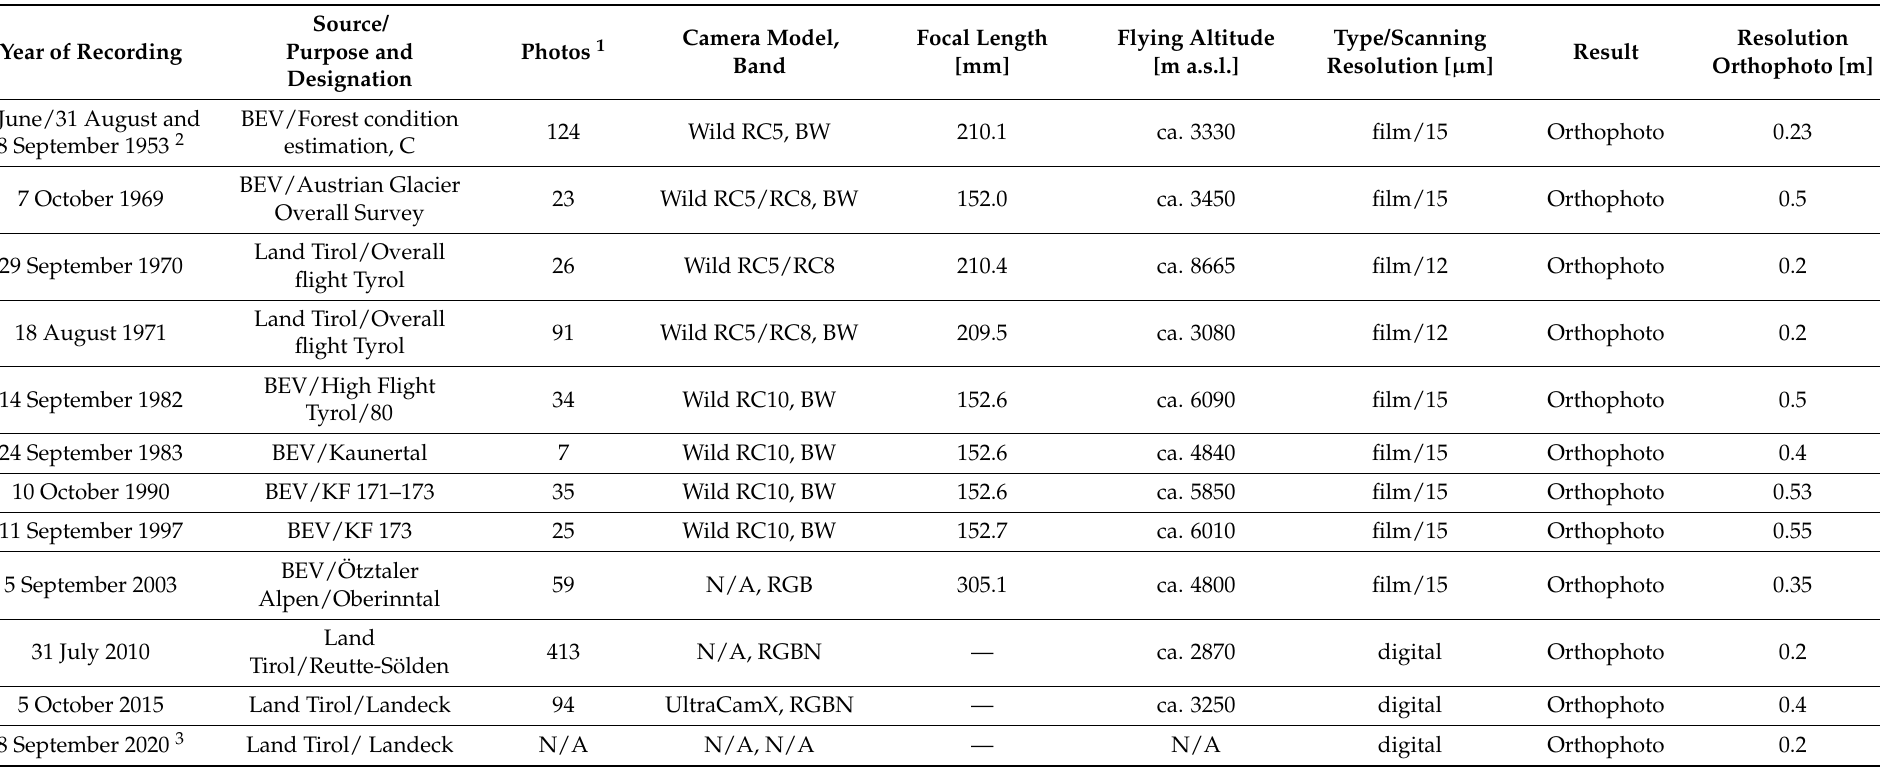
Table A1. Attributes of historical and current aerial